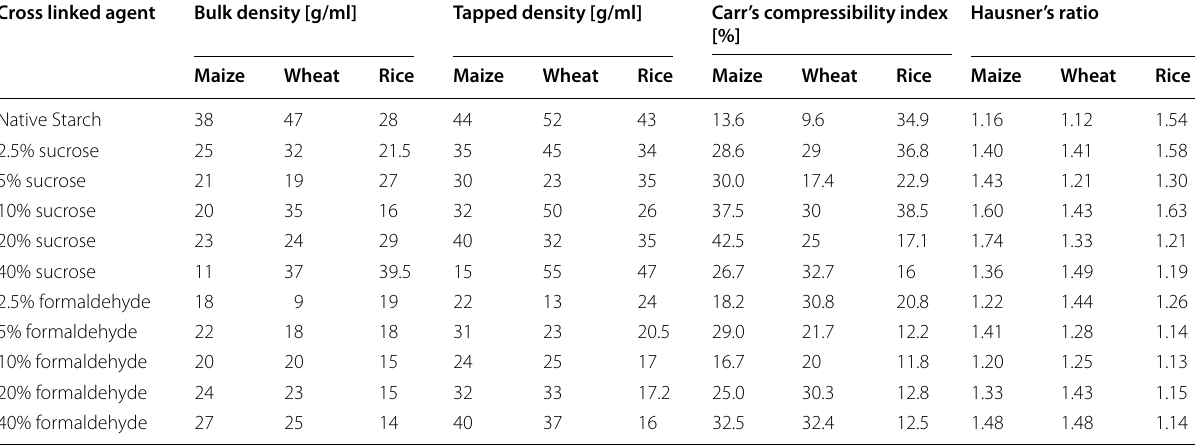
Table 2 The bulk and tapped densities of the cross-linked three starches Cross linked agent